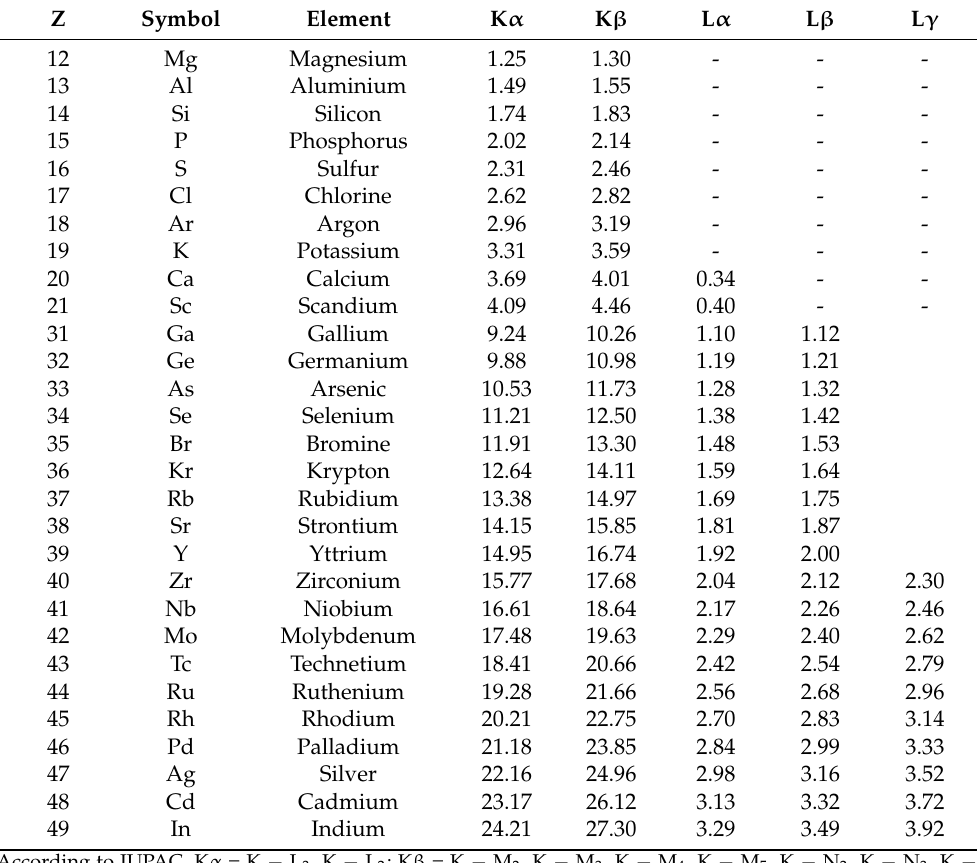
Table 3. Energies (keV) of K and L lines